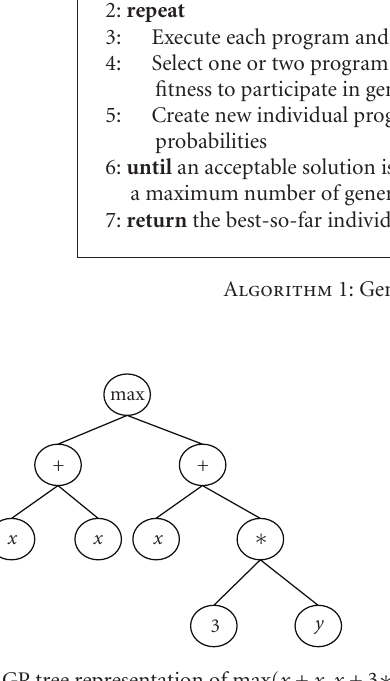
Figure 4: GP tree representation of max( x + x , x + 3 ∗ y ) .